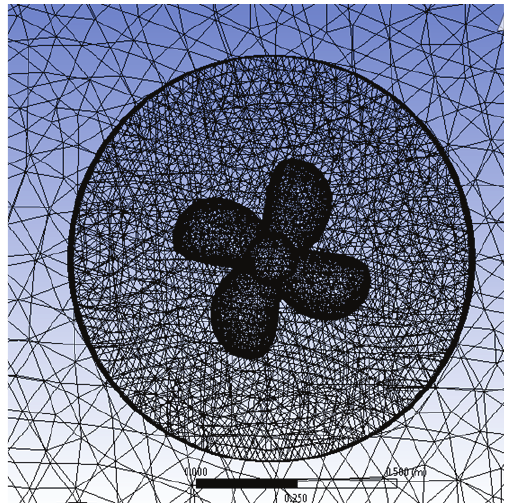
Figure 3: Final mesh for the calculation domain.